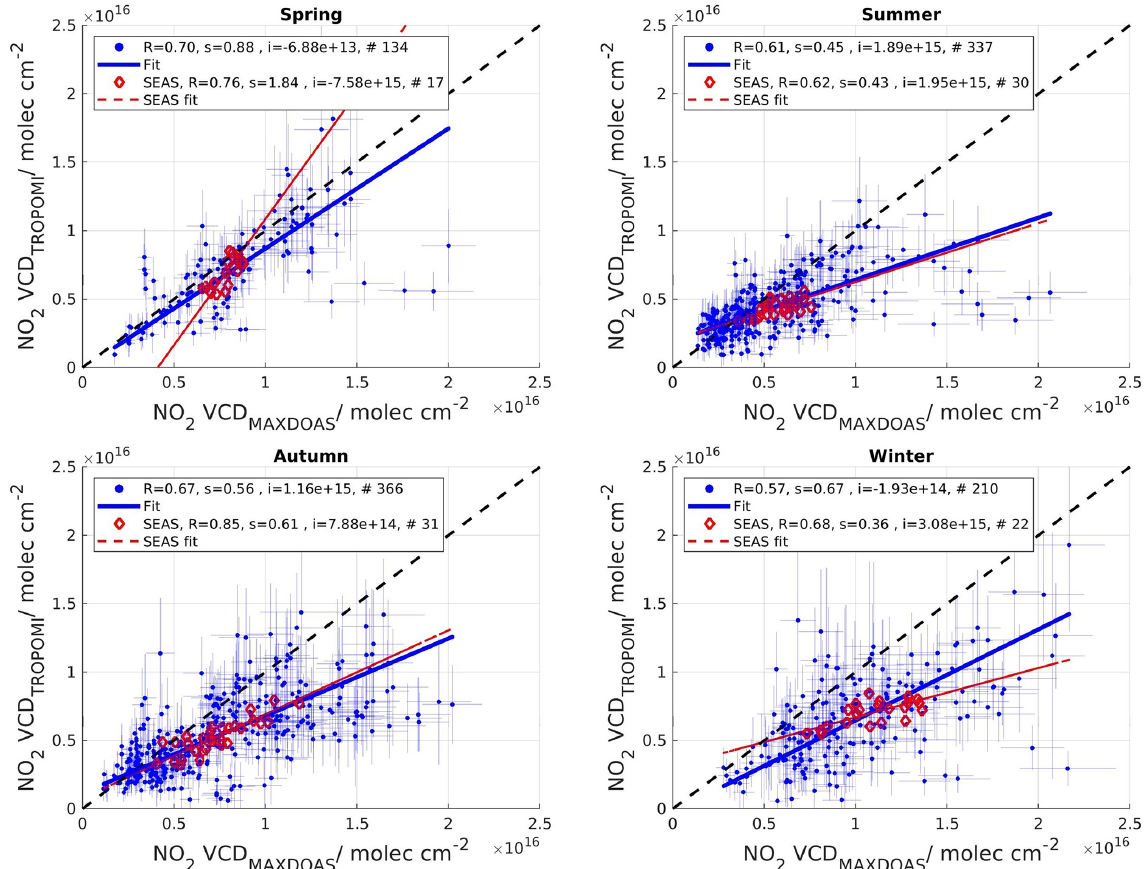
Figure 23. Seasonal scatter plots of tropospheric NO 2 columns derived from the dual-scan MAX-DOAS and TROPOMI measurements over Brussels. Blue line: regression analysis results when all the MAX-DOAS and TROPOMI pixels are included in the comparison. Red line: seasonal average analysis generated by the pixels in Fig.